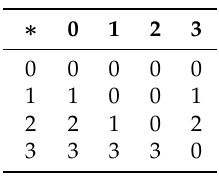
Table 1. Cayley table for the binary operation “ ∗